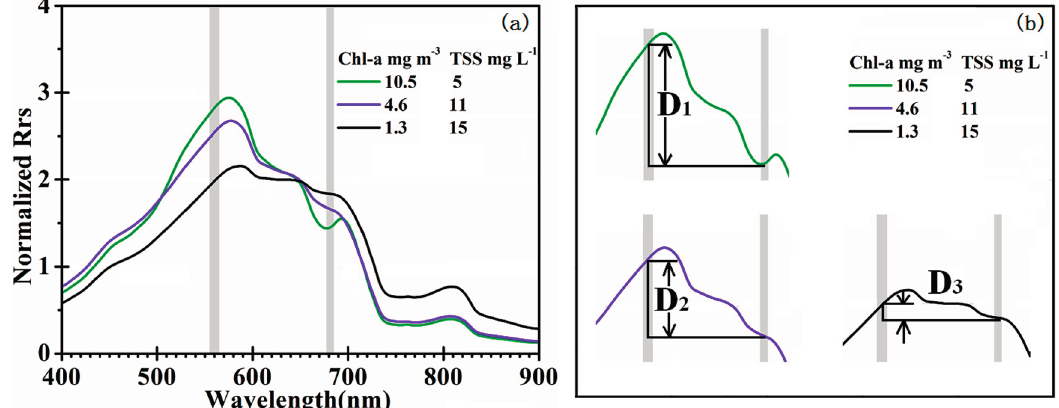
Figure 3. ( a ) Comparison of the normalized R rs with different Chl-a concentrations. The relative difference between MERIS 560- and 681-nm bands (D i of ( b )) increases with elevated